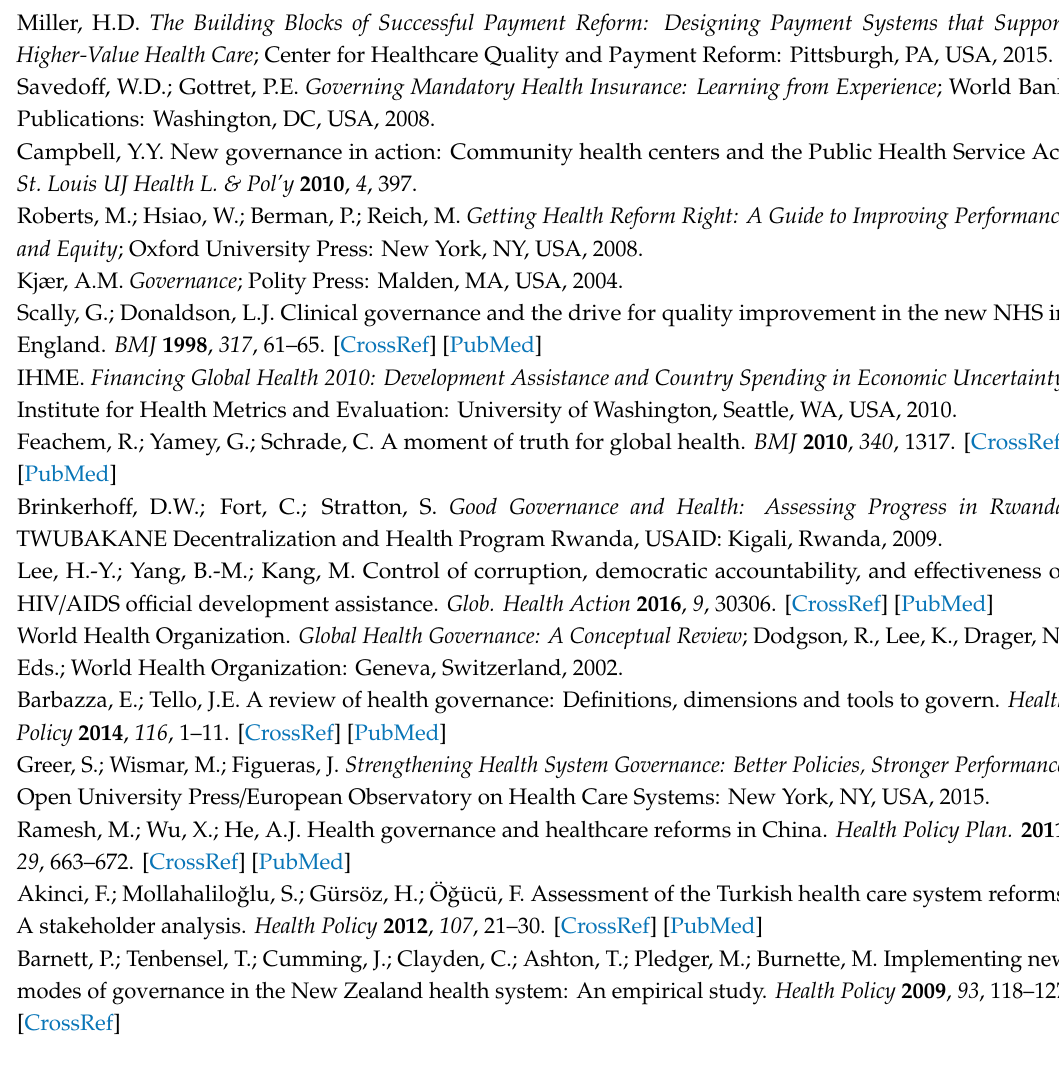
Figure A2. Coding frequency (%) by stakeholders.